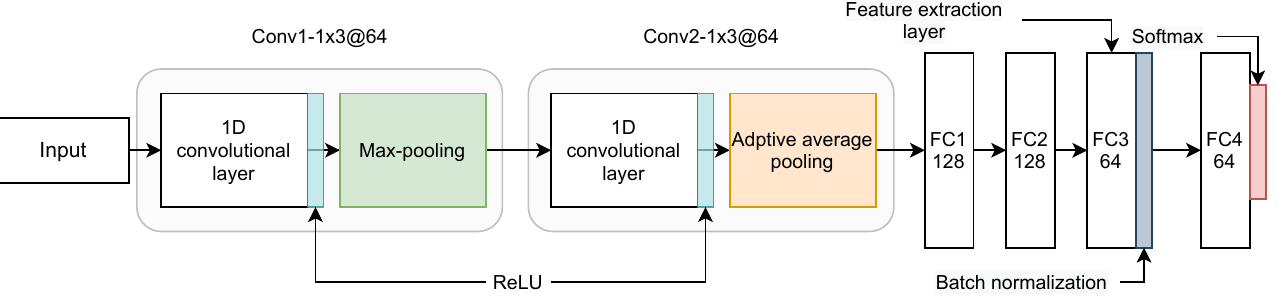
Figure 2. The feature extraction module based on a proposed CNN